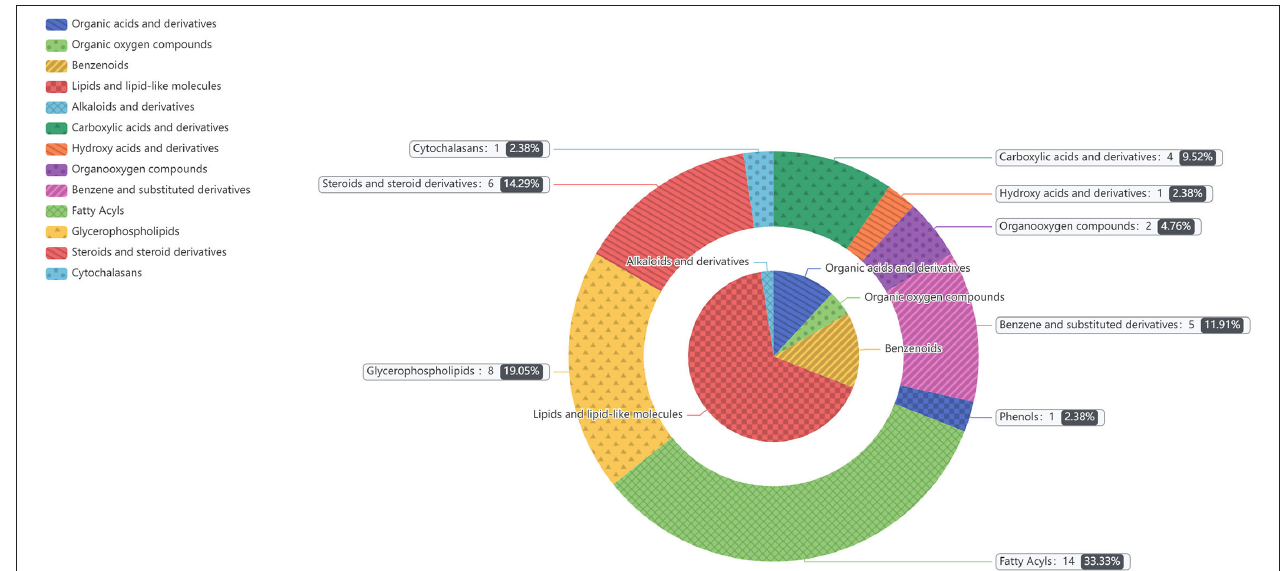
FIGURE 6 | The different metabolites in plasma between NCG group ( N = 8) and CON group ( N = 6) are classified according to the HMDB Compound Classification. The inner pie chart is the classification of the differential metabolites in the Super Class, and the outer pie chart is the classification of the differential metabolites in the Class, and the Class belongs to the Super Class. The contents of gray box corresponding to the outer pie guided by the indicator line represents the name of the Class, the number and proportion of differential metabolites in the